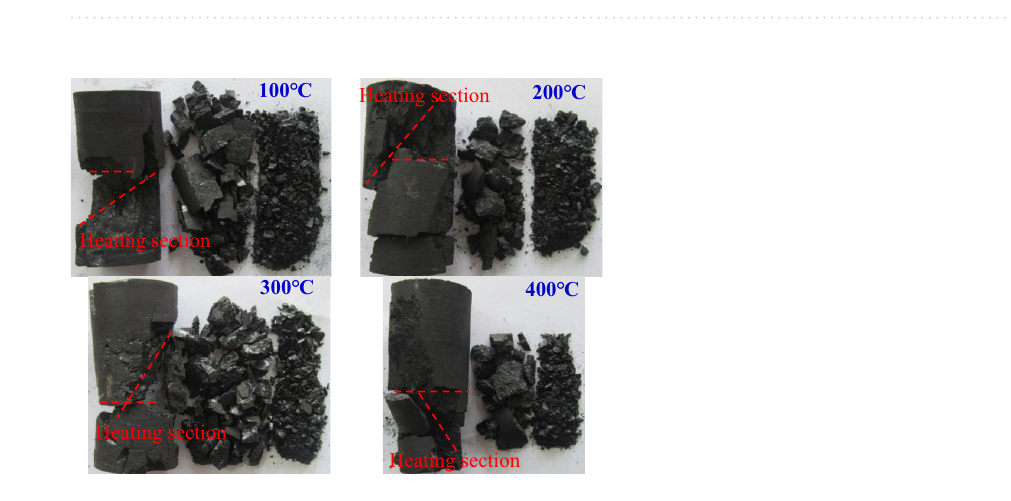
Figure 13. Verification of acoustic emission parameters reflecting coal sample strength (Heating temperature is 200 °C).